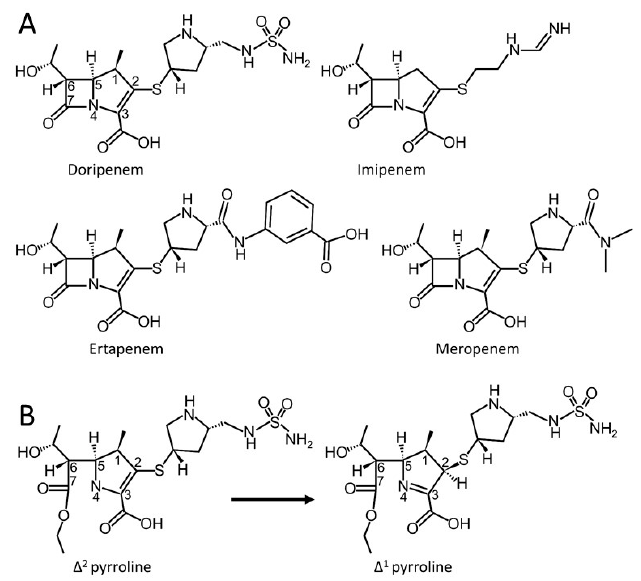
Figure 1. Structures of doripenem, imipenem, ertapenem, and meropenem ( A ) Chemical structures of doripenem, imipenem, ertapenem, and meropenem; the left side of each carbapenem contains the R1 hydroxyethyl side chain that is present in all carbapenems, while the right side of the molecules is denoted as the R2 side chain, which varies in chemistry in different carbapenems. ( B ) Tautomerization states of the acyl intermediate of doripenem in Δ 2 and Δ 1 R forms.